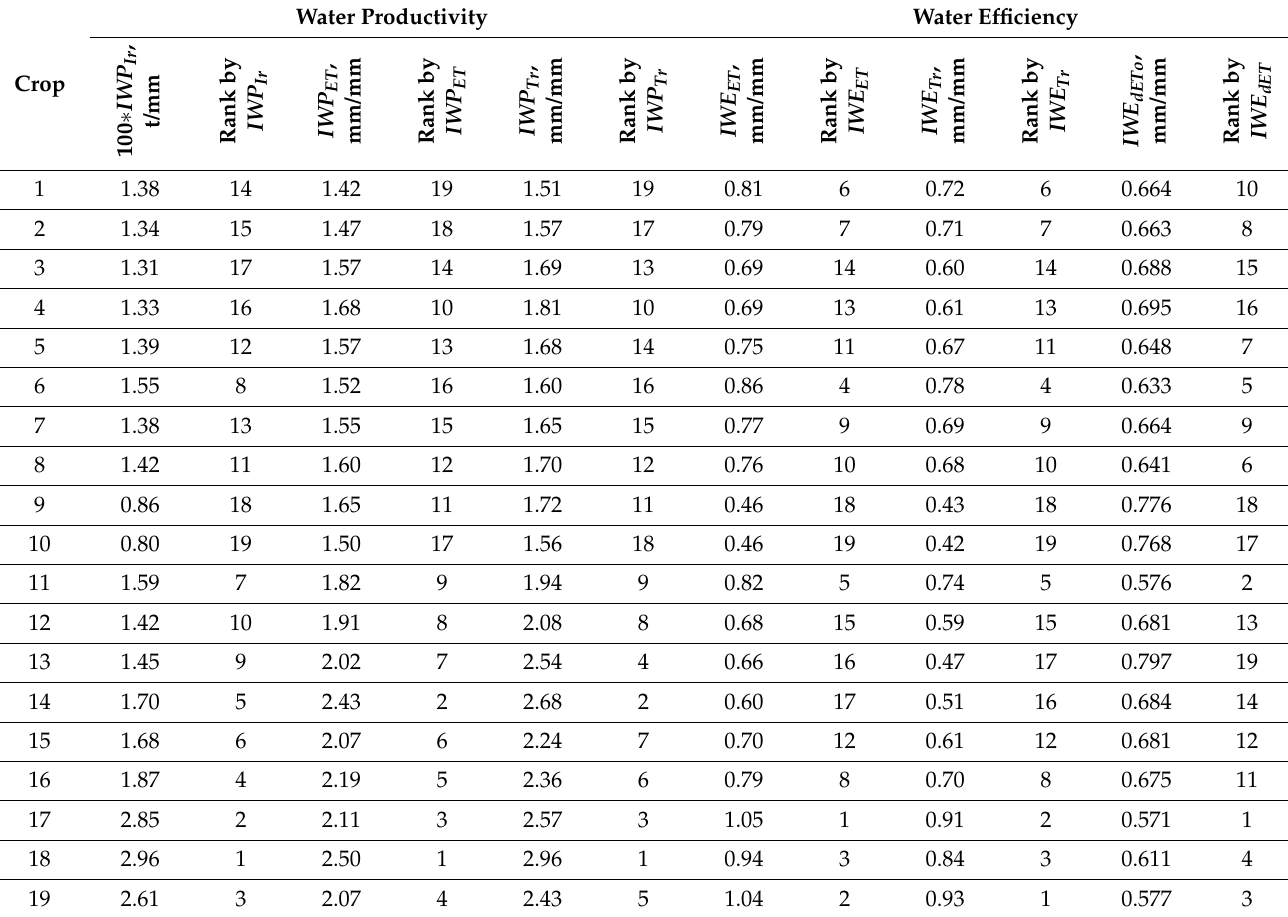
Table 1. Crops ranking according to the values used under the analysis of the efficiency of